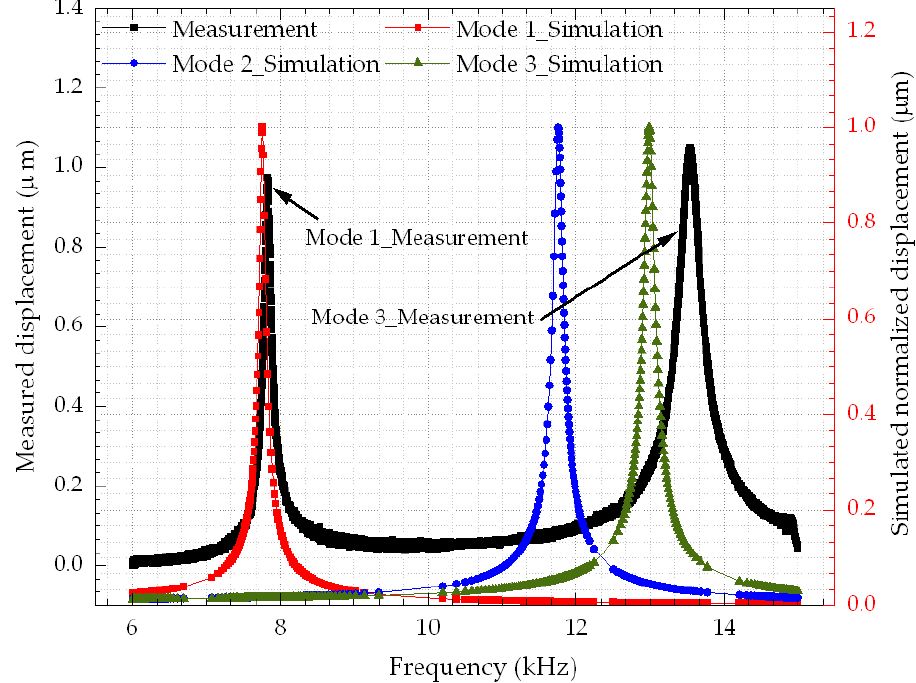
Figure 10. Measured frequency response of D1 showing two resonant modes along with the simulation results. Table 2. Measured resonant frequency modes of the devices.